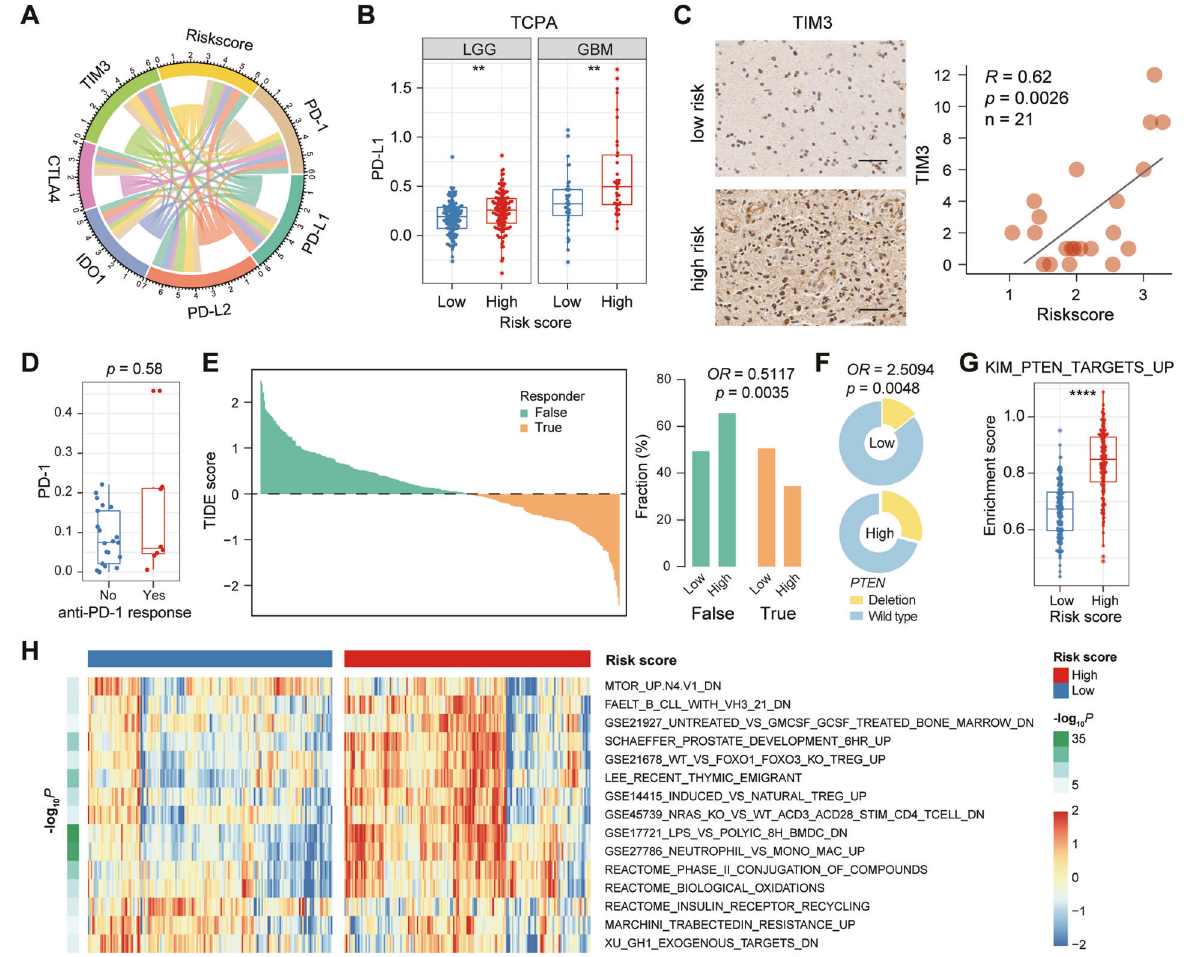
Fig. 7 The relationship between risk score and tumor immune response. A The correlation coef fi cient between risk score and immune checkpoints. B The distribution of PD-L1 protein level in the high- and low-risk groups based on the TCPA datasets. **, p < 0.01. C The distribution of TIM3 protein level in the high- and low-risk groups by IHC staining. Scale bar, 50 μ m. D The distribution of PD-1 expression in GBM patients before treatment with PD-1 inhibitors. **, p < 0.01. E The TIDE score and response results to immunotherapy of patients with glioma. F Fraction of PTEN loss in the low-risk group versus high-risk group. G GSEA enrichment score of gene-set KIM_PTEN_TARGETS_UP for the low-risk group versus high-risk group. ****, p < 0.0001. H Heatmap showing the gene sets differentially enriched in the low-risk group versus high-risk